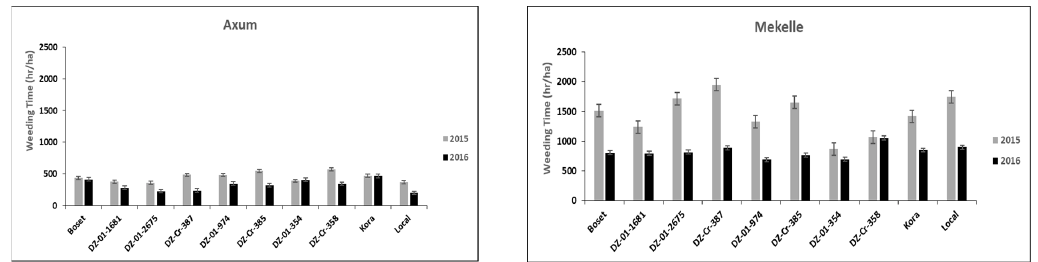
Figure 5. The effect of the different teff varieties on weeding time.